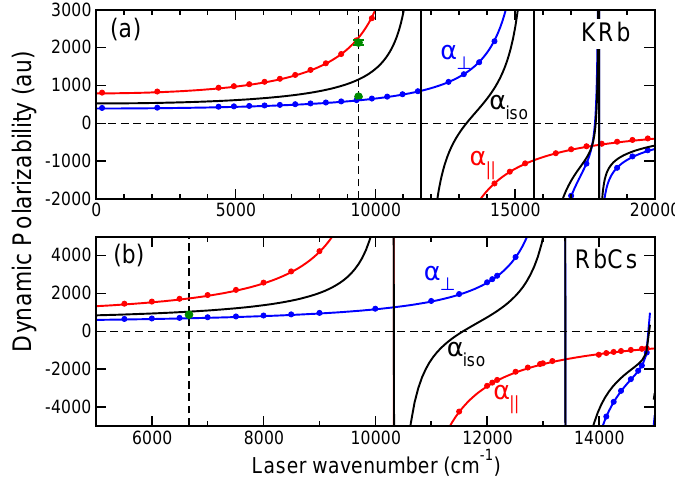
Figure 5. The CCLR polarization contribution to the molecular dynamic polarizability of the X 1 Σ + ground state of KRb ( a ) and RbCs ( b ) at their equilibrium separation in atomic units as functions of laser wavenumber. Red, blue, and black curves and markers correspond to the parallel α || , perpendicular α ⊥ , and isotropic ¯ α = α iso dynamic polarizability, respectively. Markers represent frequencies on which the polarizabilities have been computed; curves are the fits. In panel ( a ) the dark green markers near 9300 cm − 1 represent the experimental results from Reference [42], while in panel ( b ) the marker near 6667 cm − 1 represents the experimental results from Reference